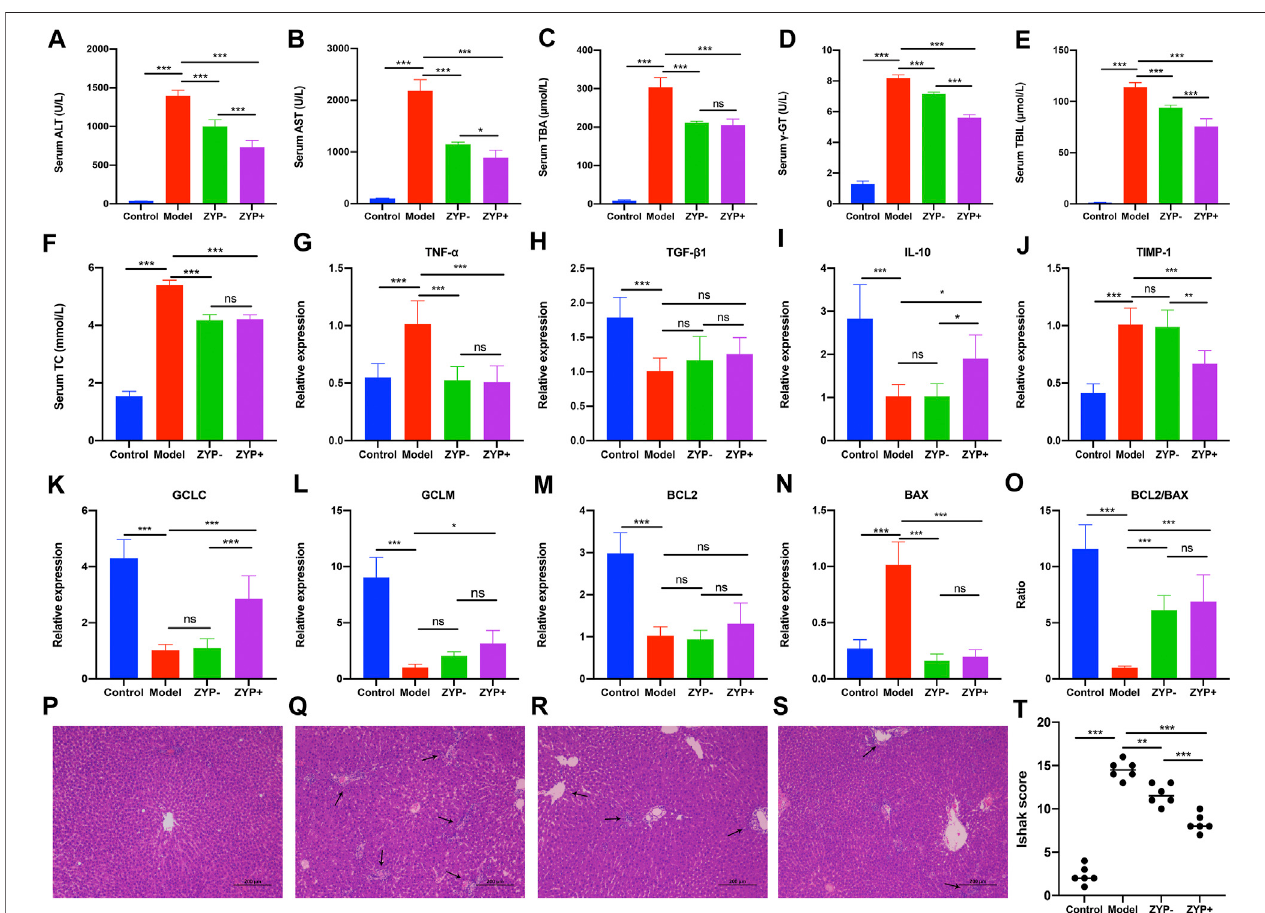
FIGURE 1 | Serum biochemistry, gene expression changes, and histopathological examination of livers evaluating liver injury in Control, Model, ZYP − and ZYP+ groups. (A) ALT; (B) γ -GT; (C) TC; (D) AST; (E) TBA; (F) TBIL; (G) TNF- α ; (H) TGF- β 1; (I) IL-10; (J) TIMP-1; (K) GCLC; (L) GCLM; (M) BCL2; (N) BAX; (O) BCL2/BAX. HistopathologicalexaminationofliverbyHEstainingatmagni fi cation × 100. (P) Control; (Q) CholestasisModel; (R) ZYP − ; (S) ZYP+.Arrowsindicatethepathologicalloci. (T) Ishak score of hepatic in fl ammation and necrosis. n (cid:2) 6, ***/**/*, p < 0.001/ p < 0.01/ p < 0.05; ns, no signi fi